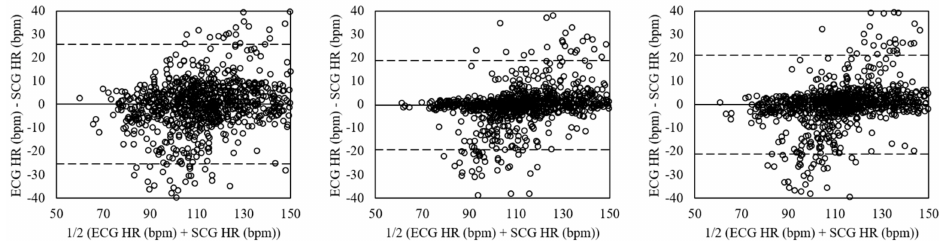
Figure 10. Bland-Altman plots of heart rates estimated from SCG and ECG by CNNs for running at movement speeds of 6.4 ( Left ), 8.5 ( Mid ), and 10.3 ( Right ) km/h based on the VGG-16 without data augmentation ( Top ), VGG-19 with data augmentation ( Mid ), and ensemble network ( Down ). The lines are the mean errors and 95% LOA.